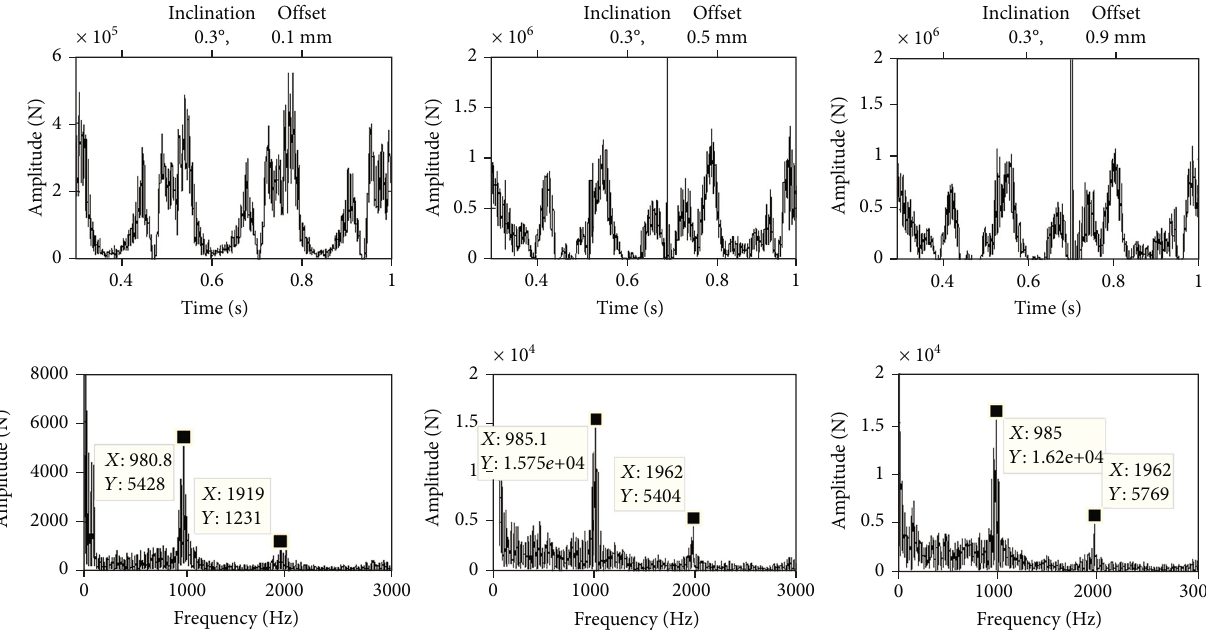
Figure 12: The time domain diagram and frequency spectrum diagram of the meshing force of sun gear and planetary gear at di ff erent o ff set positions.